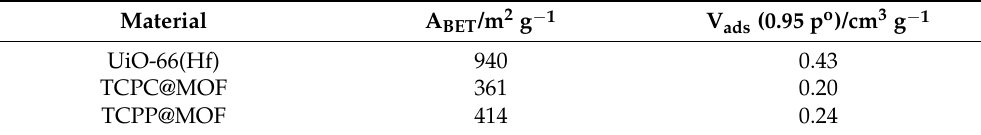
Table 1. BET area (A BET ) and adsorbed N 2 volume for UiO-66(Hf), TCPC@MOF and TCPP@MOF. Material